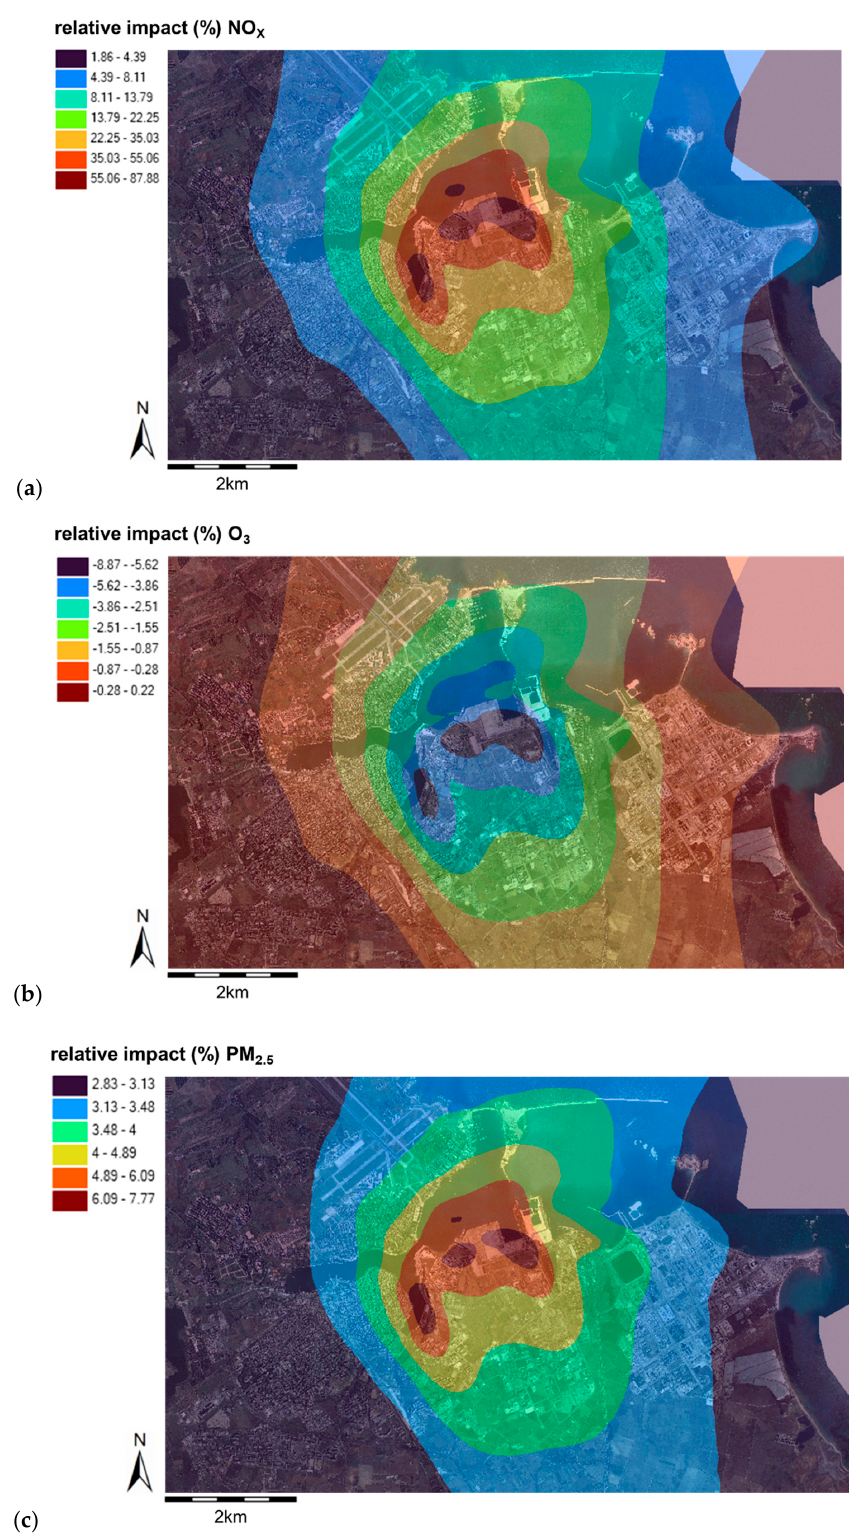
Figure 7. Average relative impact of ship emissions (%) on ( a ) NO X , ( b ) O 3 , and ( c ) PM 2.5 concentrations obtained from ADMS-Urban at 2 m for the whole period June–October 2012. Table 6. BOLCHEM e stimated impact of ship emissions pollutant concentrations in the port area. BOLCHEM % Impact NO X